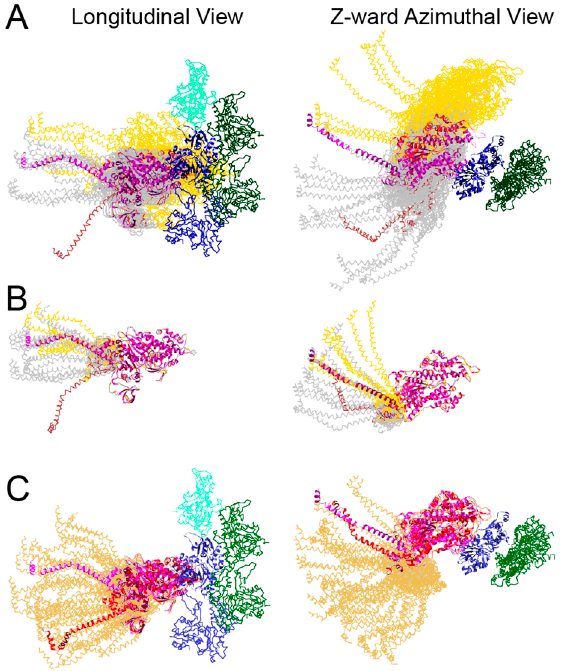
Figure 8. Range of lever arm positions for strongly and weakly bound cross-bridges in isometrically contracting Lethocerus flight muscle. Ribbon diagrams of actin subunits are colored blue and green. Ribbon diagrams are shown for only the heavy chains of myosin. ( A ) All weak binding cross-bridges superimposed on actin subunit I (see Figure 6). This view illustrates the variations in MD position when referred to a single actin subunit. Chain traces of Type 1 bridges are shown in gray and Type 2 bridges in yellow. The single post-rigor conformation found is colored light brown. Note the relatively small axial dispersion of the Type 1 MDs compared to the broad dispersion of the Type 2 MDs; ( B ) all weak-binding cross-bridges aligned on the scallop transition state MD to illustrate lever arm variations compared with the starting scallop S1 structure. Coloring scheme is the same as for panel A; ( C ) rebuilt models of strong-binding cross-bridges are colored (gold) superimposed on both starting myosin head structures (red and magenta) as docked onto actin in the strong binding configuration. Adapted from [34].